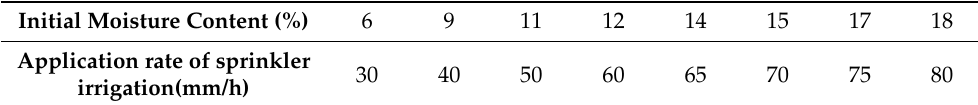
Table 2. Initial water content and application rate of sprinkler irrigation.